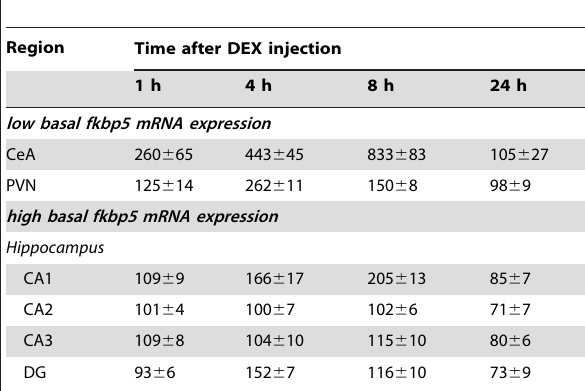
Table 4. Increase in fkbp5 mRNA following dexamethasone